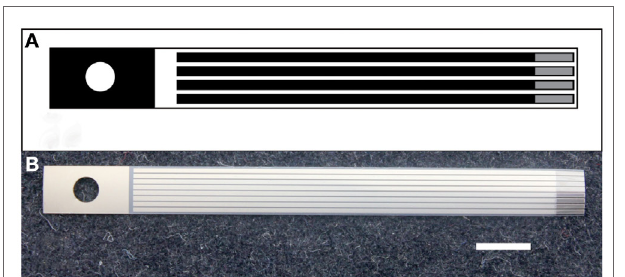
FigUre 4 | representative peel test raw data from (a) PP and (B) PMP test devices . The edge effect observed for the PP device was not observed for the PMP device, most likely due to the force magnitude of being dominated by the larger PMP average peel strength (~50 times larger). Note that the two plots are on different